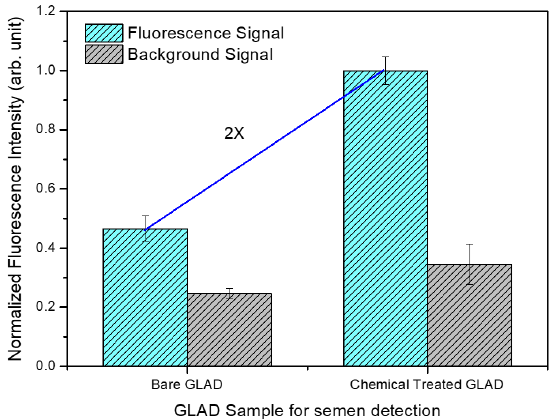
Figure 3. Comparison of the normalized fluorescence intensities in the semen detection experiment (12 ug/mL semen sample) using the bare GLAD HSV-ID chip and chemically-treated HSV-ID chip.